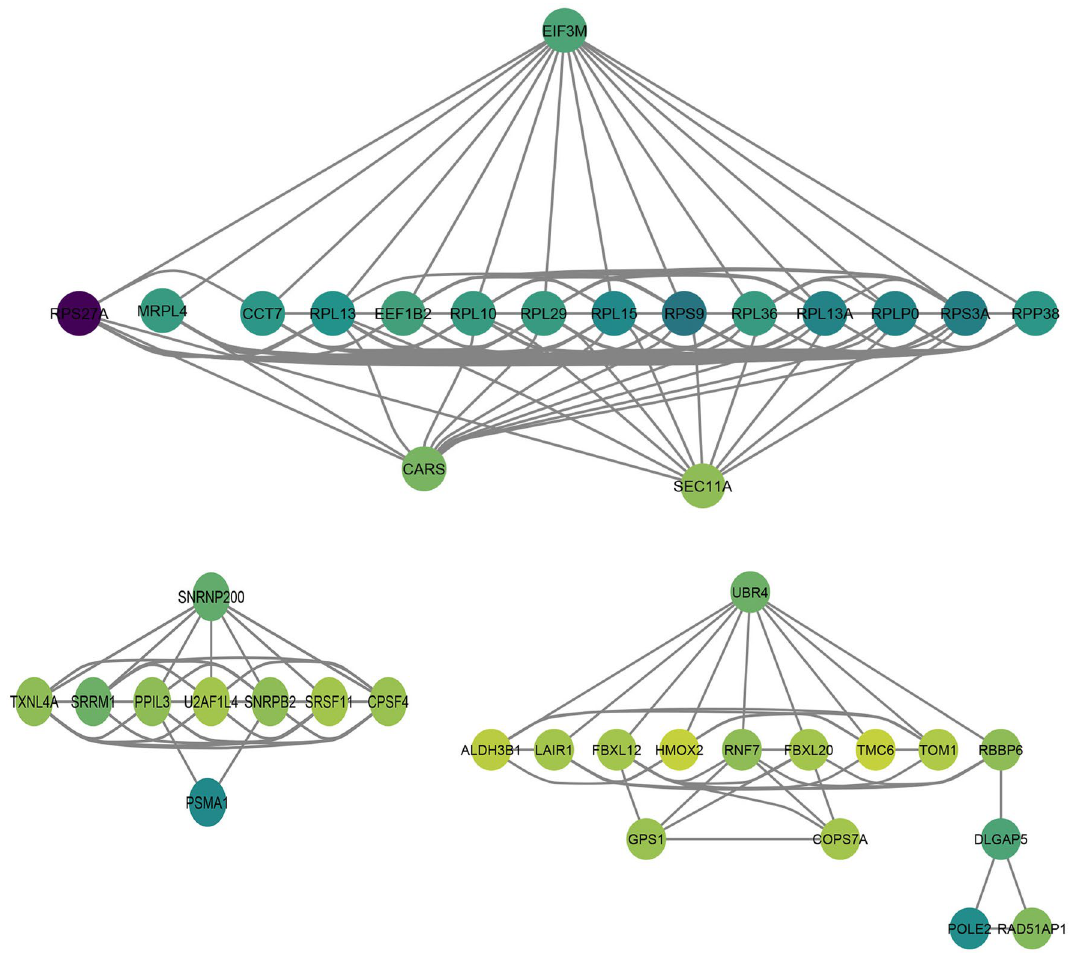
Figure 3. Interaction network of genes with survival-associated AS events in ovarian carcinoma generated by Cytoscape. The more interactive point in the network, the more important it is. Hub genes at EIF3M, RPS27A, SNRNP200 and UBR4 in gene